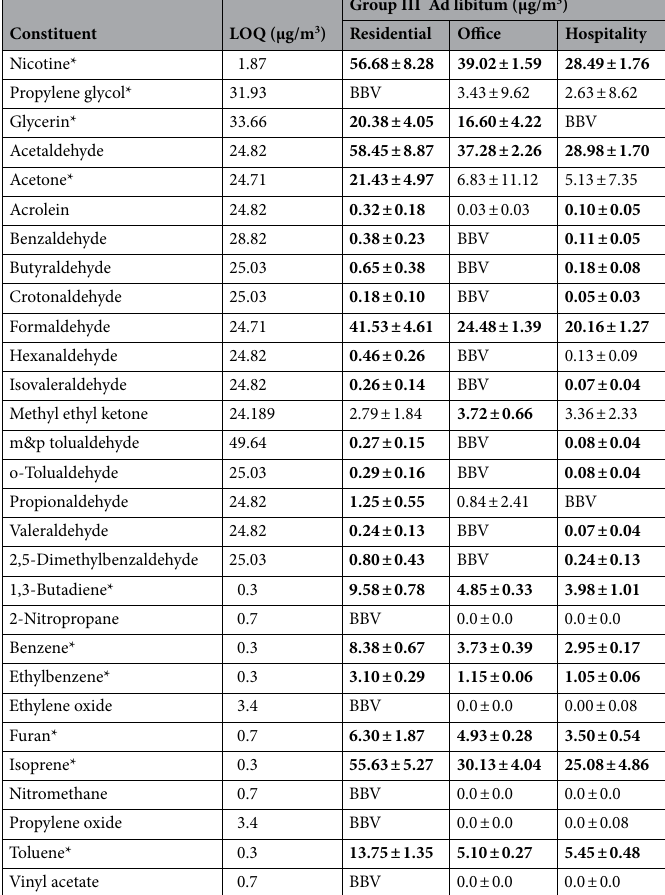
Table 5. Mean (± SD; N = 4) cumulative (4-h) constituent concentrations changes from baseline values for Group III for any constituent detected above LOQ for at least one puffing regimen for any group. Statistically significant constituent values from baseline (p < 0.05) are in bold. Statistically significant differences (p < 0.05) found in baseline concentrations (N = 4) between ventilation conditions are denoted with an asterisk. BBV Below baseline value, LOQ Limit of Quantification is based upon the amount of air sampled and is a composite average from all 4 air samplers used in the three